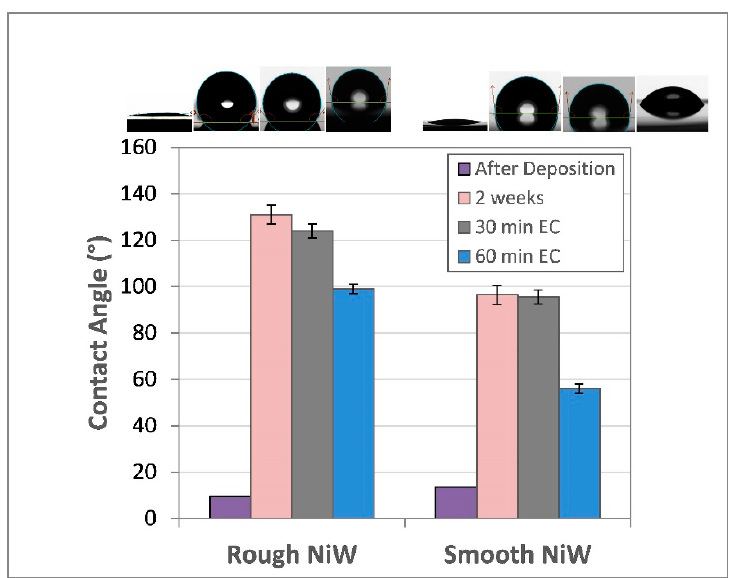
Figure 9. Changes in the water contact angle of NiW coatings quickly after electrodeposition, after two storage weeks in air and after erosion – corrosion (after removing, washing, drying and two weeks of storage in the air).